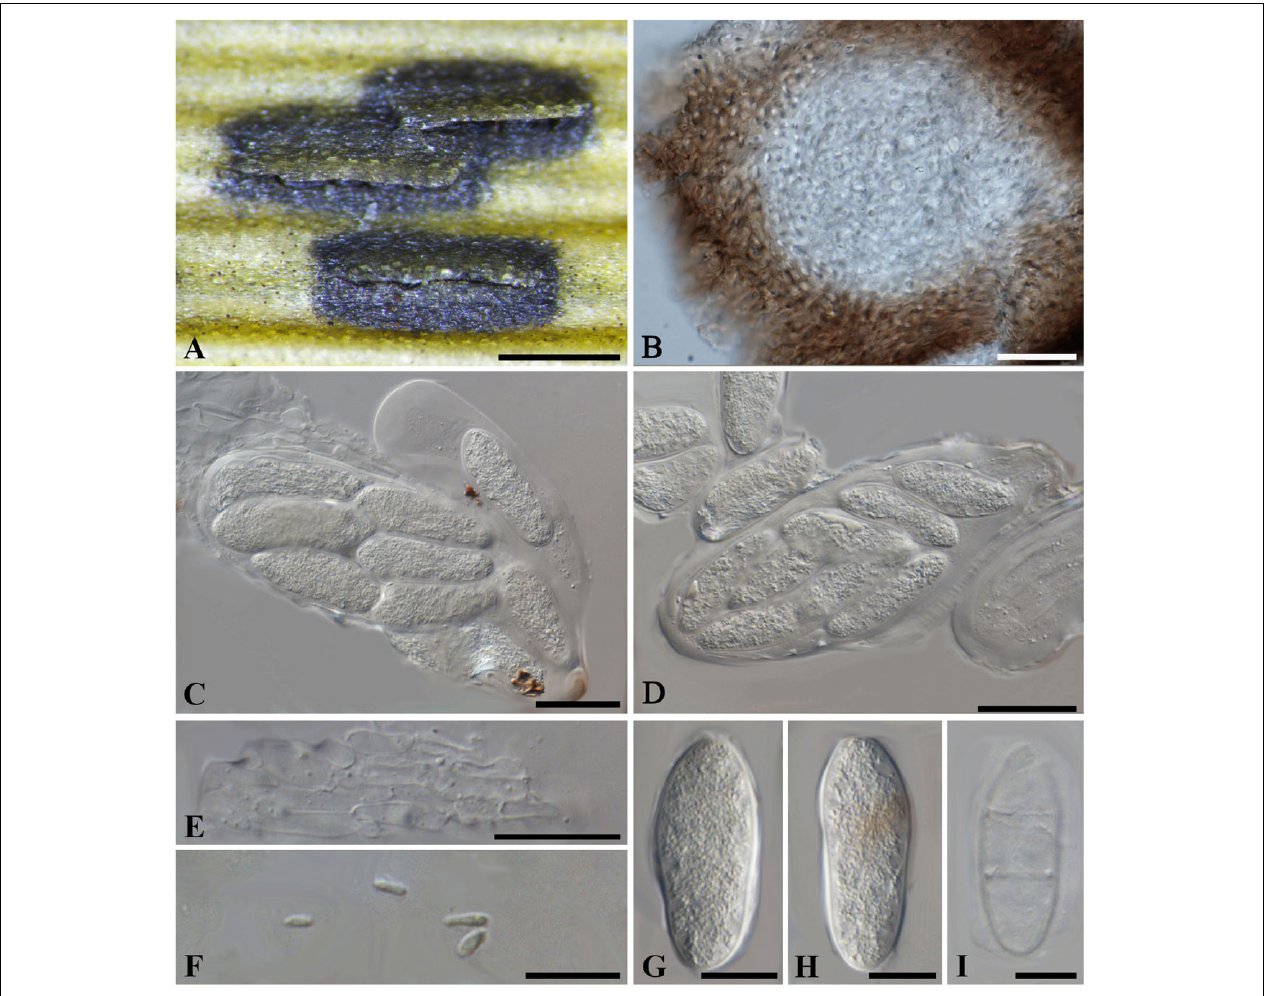
FIGURE 9 | Botryosphaeria dasylirii (NYS f950, holotype ). (A) Ascostroma erumpent through the leaf surface. (B) Section of the ascoma showing the peridium. (C) Ellipsoidal to narrowly fusiform asci. (D) Breaking asci with released ascospores. (E) Septate pseudoparaphyses. (F) Spermatia. (G,H) Hyaline aseptate ascospores with granular content. (I) Aged, 2-septate, hyaline ascospores. Scale bars: (A) = 500 µ m, (C-E) = 20 µ m, (B,F-I) = 10 µ m.